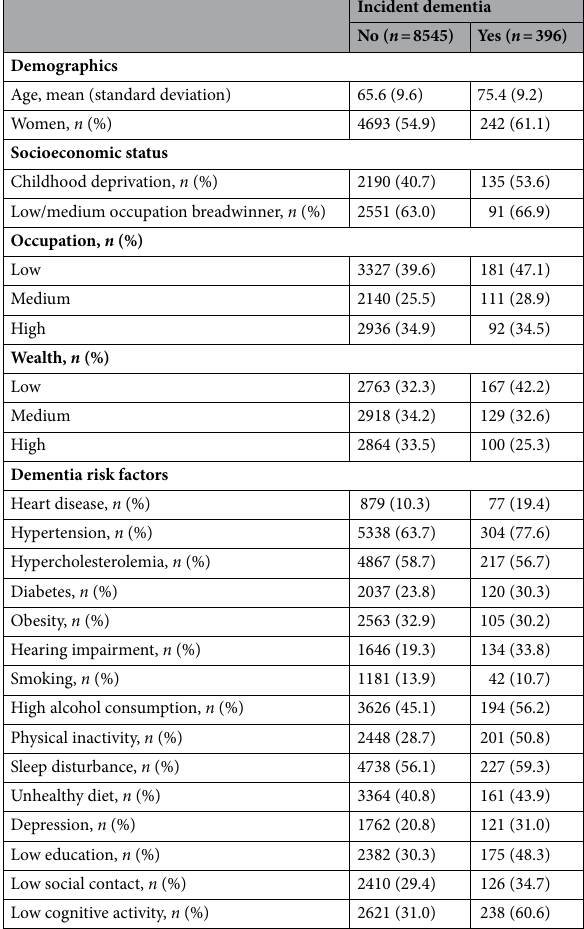
Table 1. Characteristics study